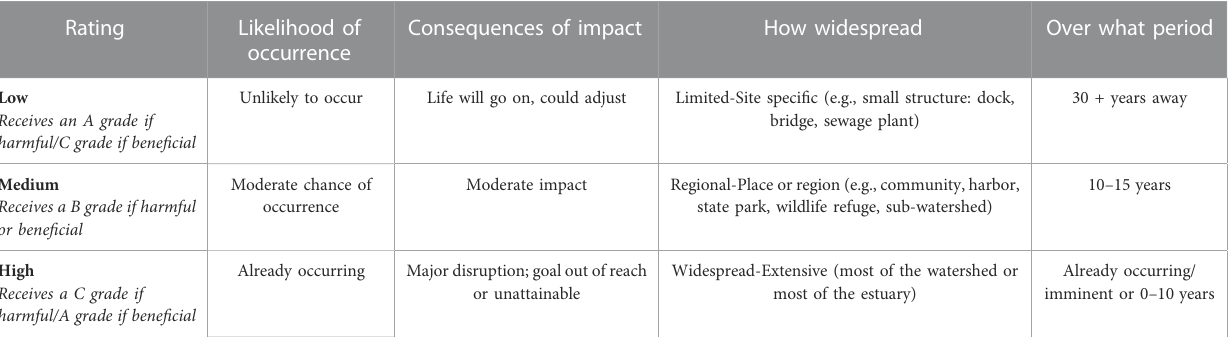
TABLE 4 Example of possible responses and corresponding